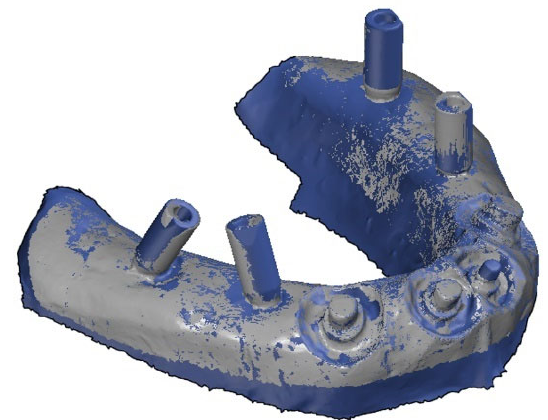
Figure 12. Alignment of the experimental (gray color) and master (blue color) 3D models using best ‐ fit method.